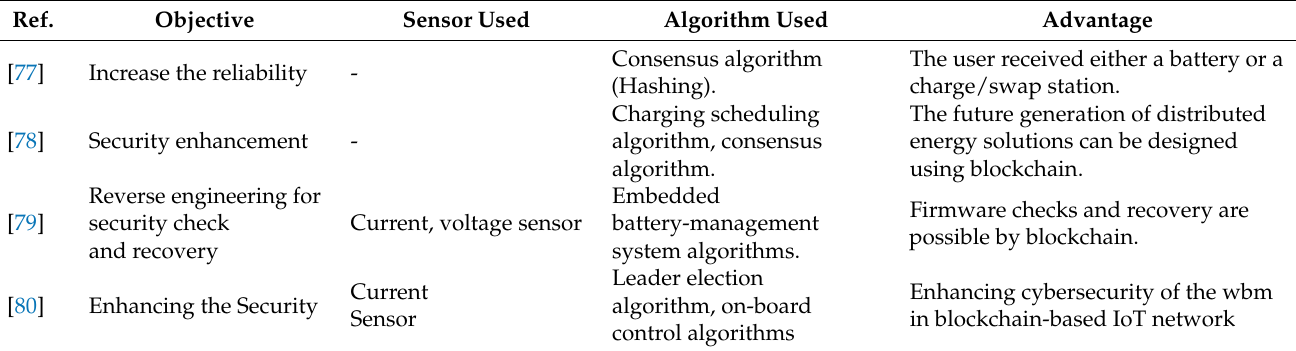
Table 9. A survey on Blockchain in battery-management systems.